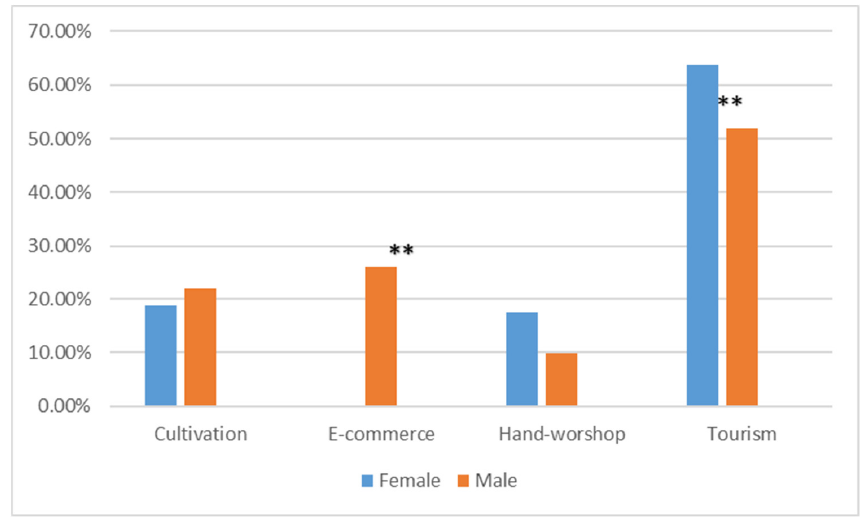
Figure 8. Variations in future industry, as perceived and preferred by female and male respondents. Asterisks indicate significance level: ** means p ≤ 0.01.